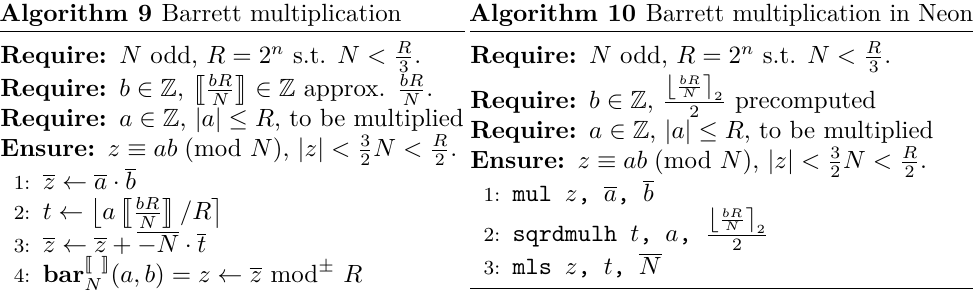
Algorithm 9 Barrett multiplication Algorithm 10 Barrett multiplication in